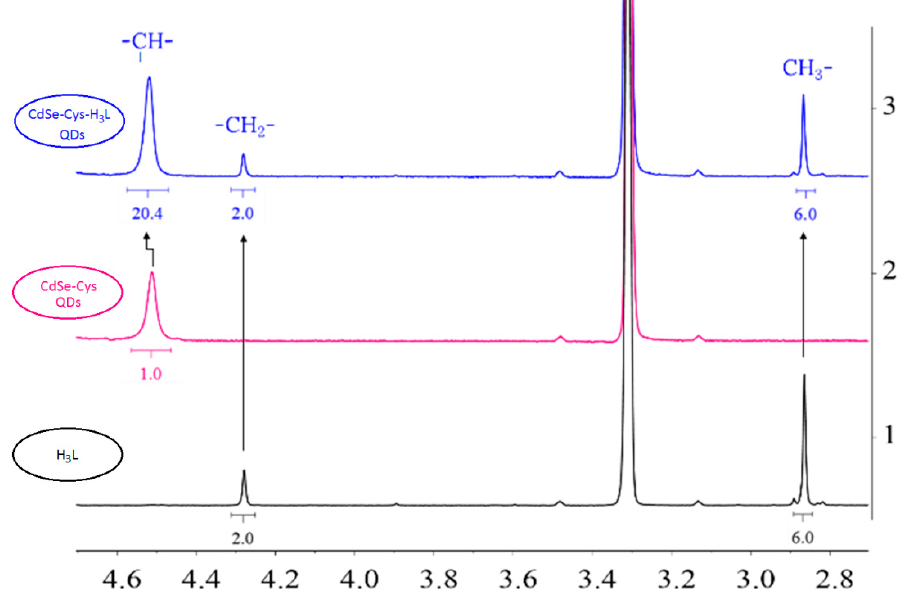
Figure 9. 1 H-NMR spectrum of the reaction product of CdSe-Cys QDs with H 3 L (range: 4.8 to 2.6 ppm) in methanol-d 4 . The spectra of CdSe-Cys QDs and H 3 L, as free species, are included for comparison. Integration values are under the corresponding signals.